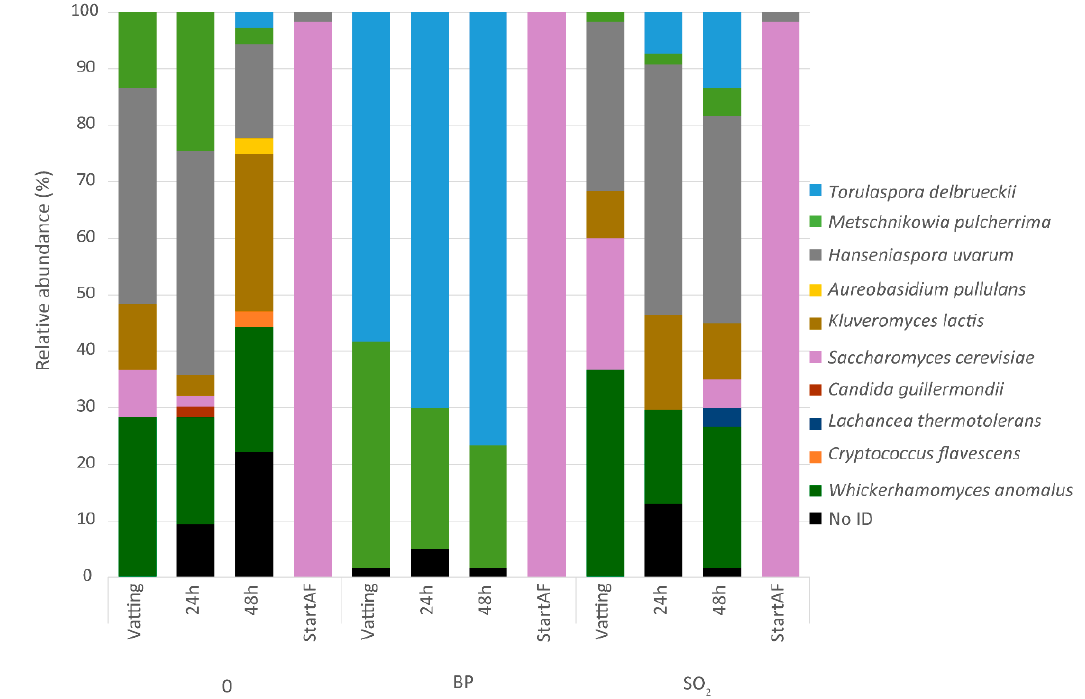
Figure 5. Relative yeast species abundance based on identification by MALDI-TOF MS according to the stages (vatting, 24 h, 48 h of maceration and start of alcoholic fermentation, StartAF) and the modality bioprotection (BP), SO 2 , and without SO 2 (0) treatments.